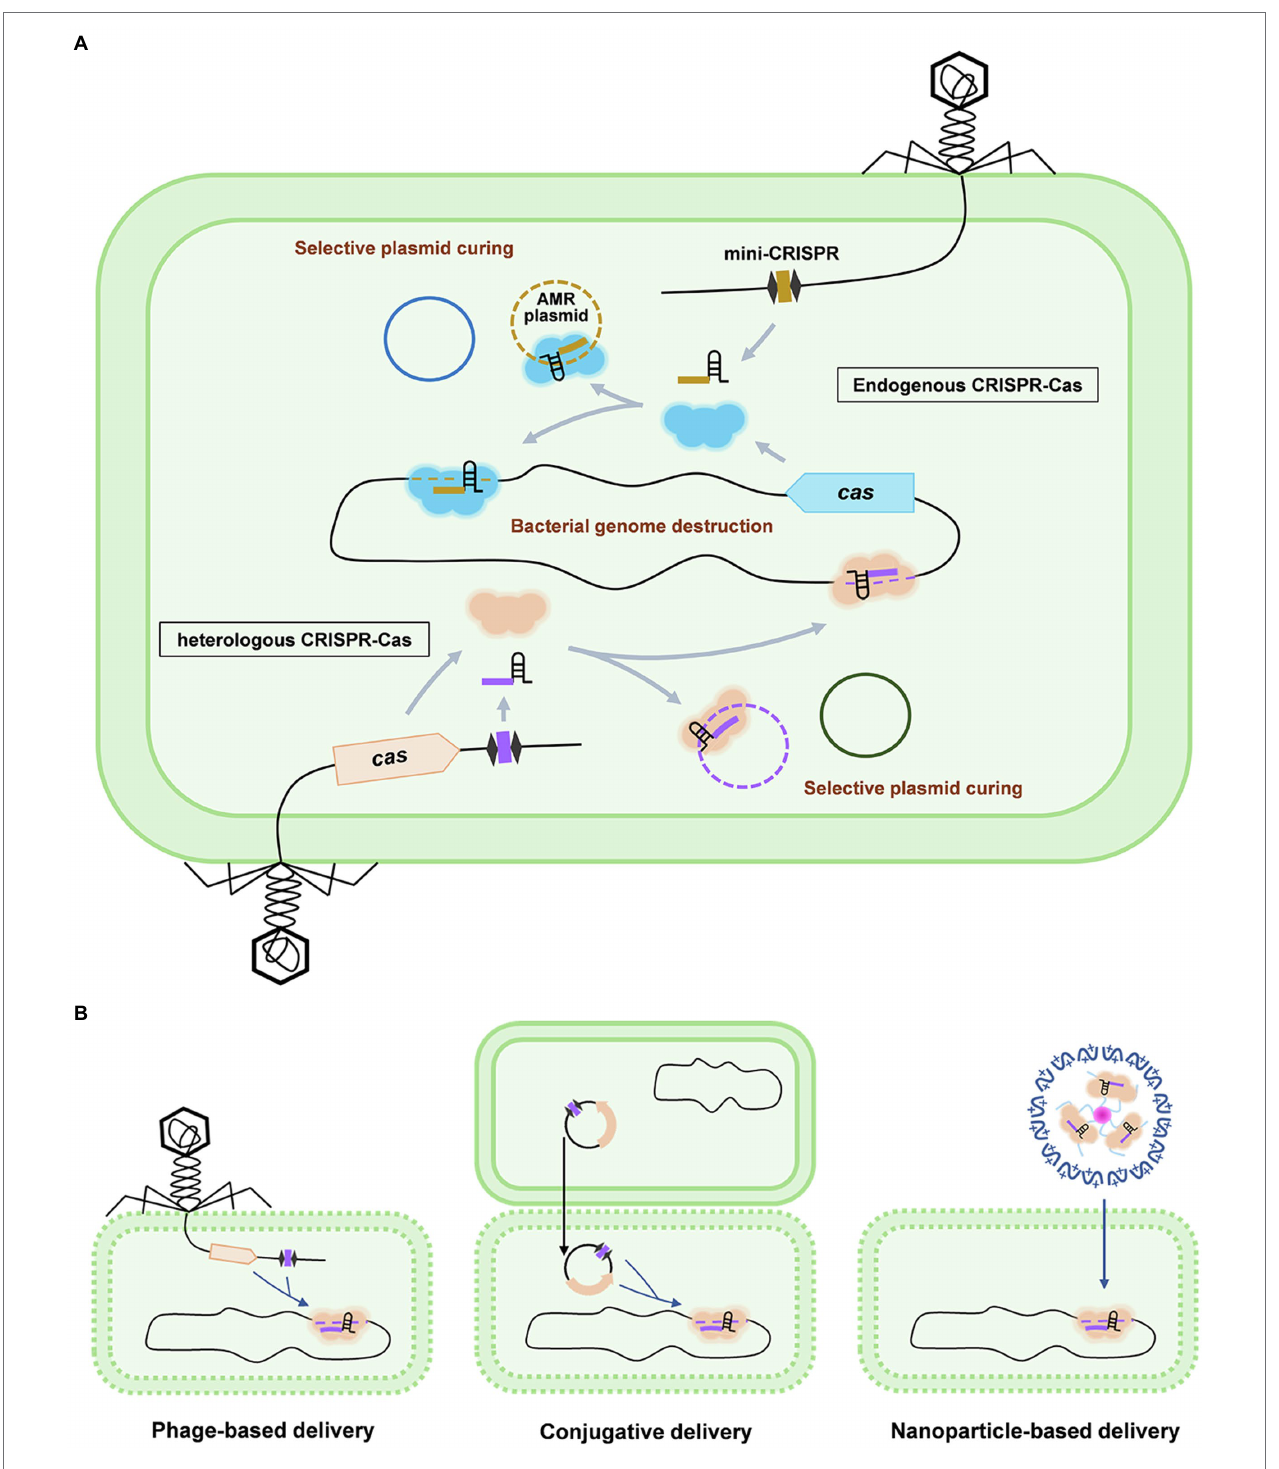
FIGURE 2 | Working mechanisms and delivery of CRISPR-Cas antimicrobials. (A) Antimicrobial applications based on the endogenous and heterogeneous CRISPR-Cas systems are shown using the phage-based delivery as an example. In the strains containing an active CRISPR-Cas system (upper panel), a single mini-CRISPR element is required to express a crRNA to guide the endogenously expressed Cas effector to specifically destruct the host genome or cure the AMR plasmid, which results in the killing or re-sensitizing of the AMR pathogens, respectively. Mini-CRISPR and cas genes can also be co-delivered into the target cells to achieve bacterial genome destruction or plasmid curing (lower panel). (B) Delivery strategies for CRISPR-Cas antimicrobials: phage-based delivery (left), conjugative plasmid-based delivery (middle), and nanoparticle-based delivery